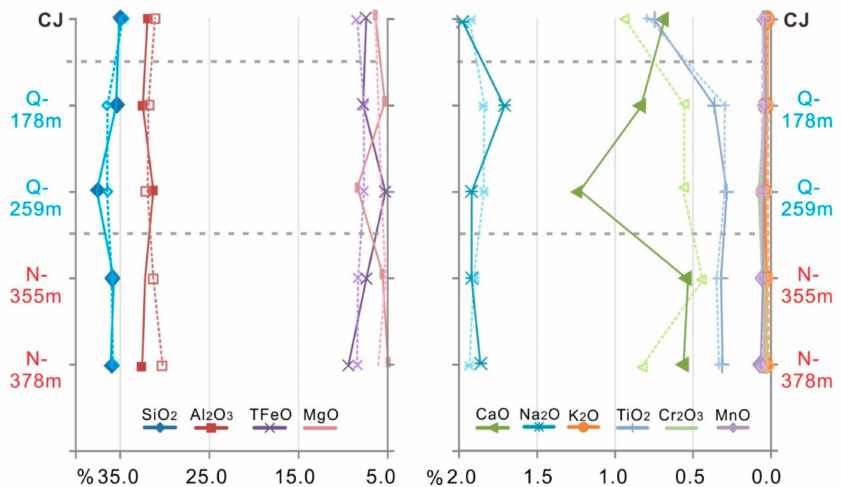
Figure 7. The mean element compositions of the tourmaline of Core LQ24 and the modern Changjiang River. A very fine sand fraction (63–125 µ m) is indicated by full lines and coarse silt (32–63 µ m) is indicated by dashed lines. The core depth is set in the vertical axis. CJ = Changjiang River. Core samples that were sampled from di ff erent depths of burial are marked in a red and light blue color. The red one is representative of the Pliocene; the light blue is representative of the Pleistocene; N = Pliocene, Q = Pleistocene. Please see Table 1 for the numbers of grains analysed per